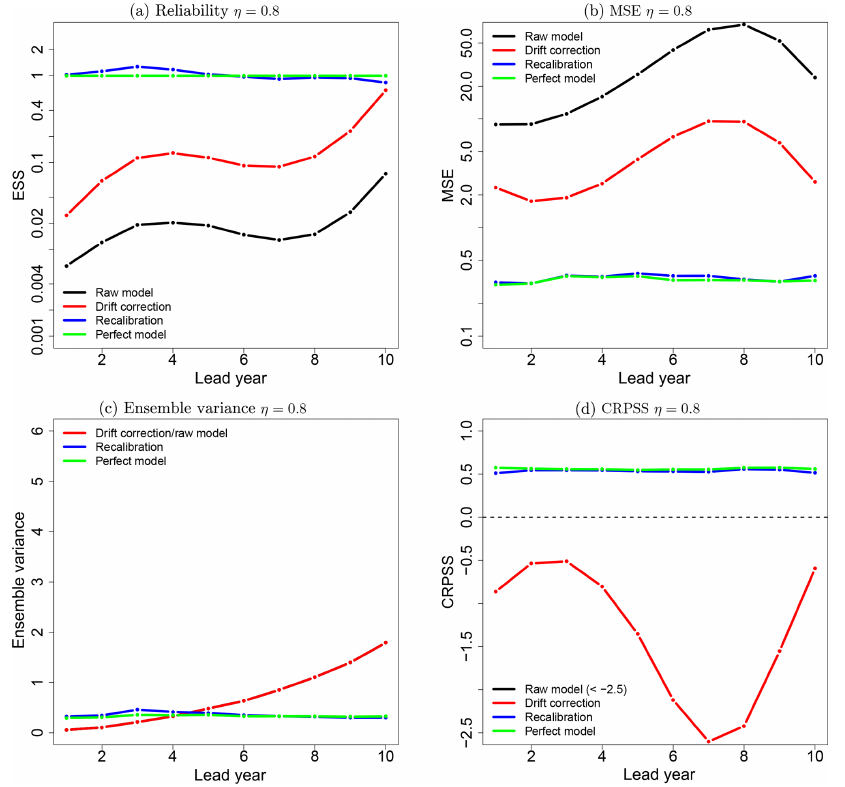
Figure 3. Reliability (a) , MSE (b) , ensemble variance (c) and CRPSS (d) of the raw toy model (black line), the drift-corrected toy model forecast (red line), recalibrated (DeFoReSt) toy model forecast (blue line) and the perfect toy model (green line) for η = 0 . 8. The drift correction method does not account for the ensemble spread; thus, the ensemble variance of the raw model and the drift-corrected forecast is equal. For reasons of clarity, the raw models’ CRPSS with values between − 5 and − 9 is not shown